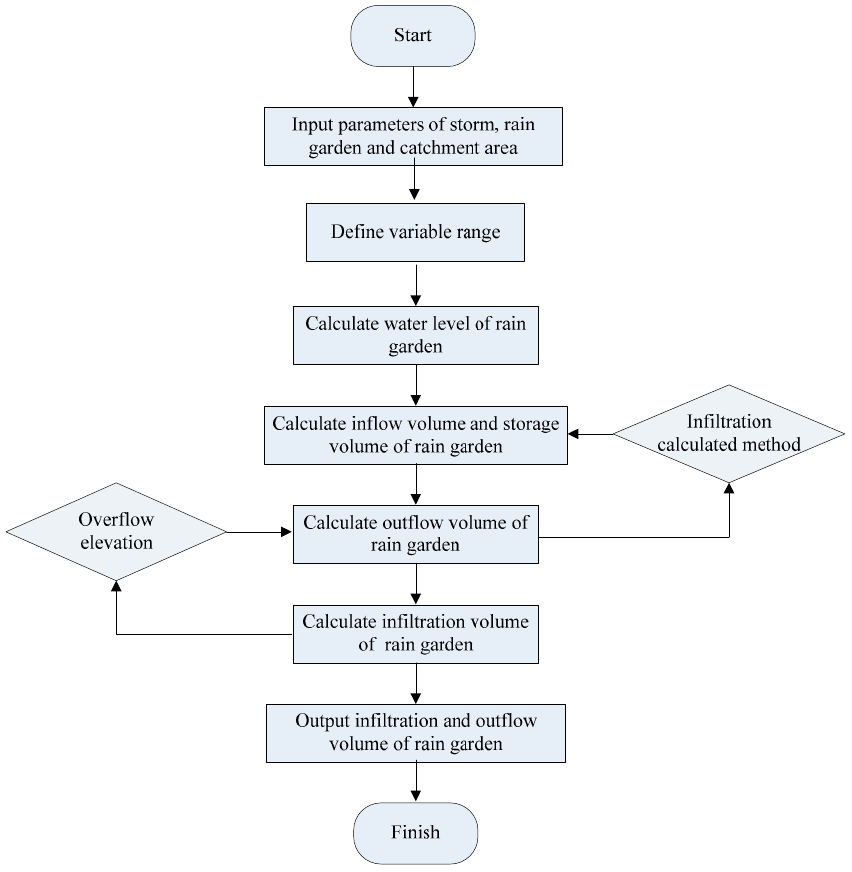
Figure 3. Flowchart of FORTRAN program used to calculate water balance in a rain garden (RG) under different storms.